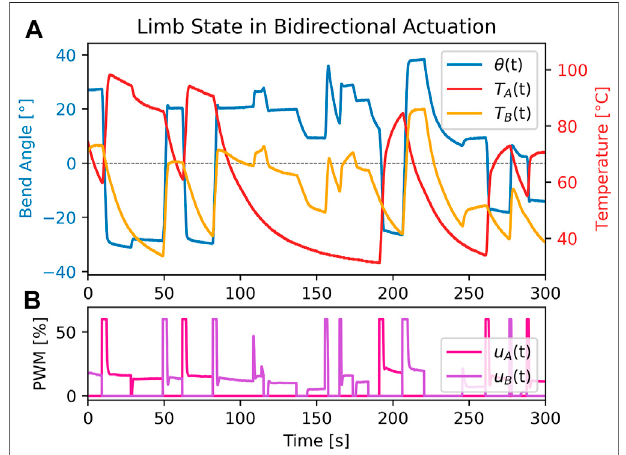
FIGURE 3 | Data collection test example, bidirectional. (A) Temperature of each SMA in the limb during test alongside corresponding limb angle. (B) PWM input into each SMA during test at corresponding